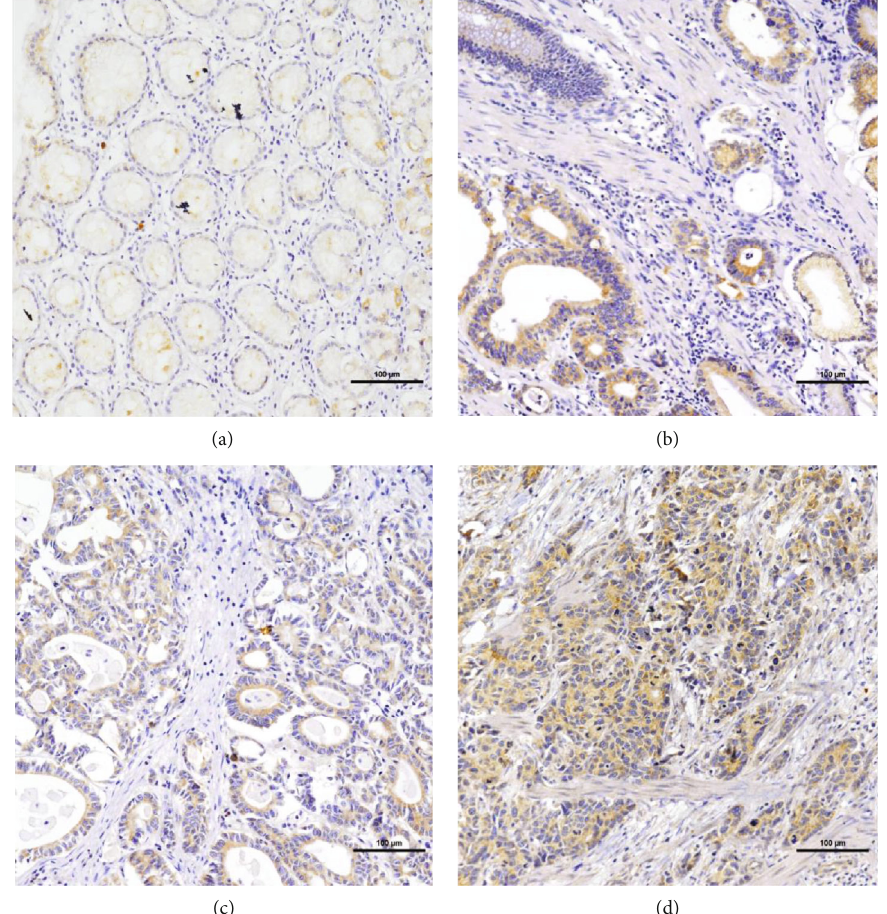
Figure 3: VSNL1 expression determined in gastric cancer lesions and noncancerous tissues by IHC; magni fi cation: × 200. (a) VSNL1 was weakly expressed in noncancerous tissues. (b, c) VSNL1 was mainly localized in the cytoplasm of cancer cells; VSNL1 was highly expressed in moderately di ff erentiated adenocarcinoma. (d) VSNL1 was highly expressed in poorly di ff erentiated ( ∗∗ ), or < 0.001 ( ∗∗∗ ). All error bars represent standard